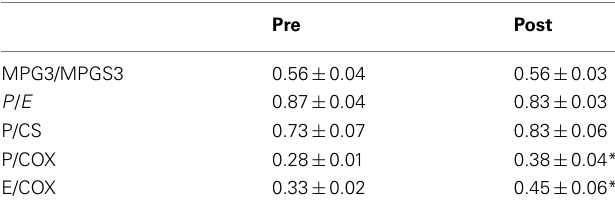
Table 2 | Mitochondrial flux control ratios before and after rhEpo